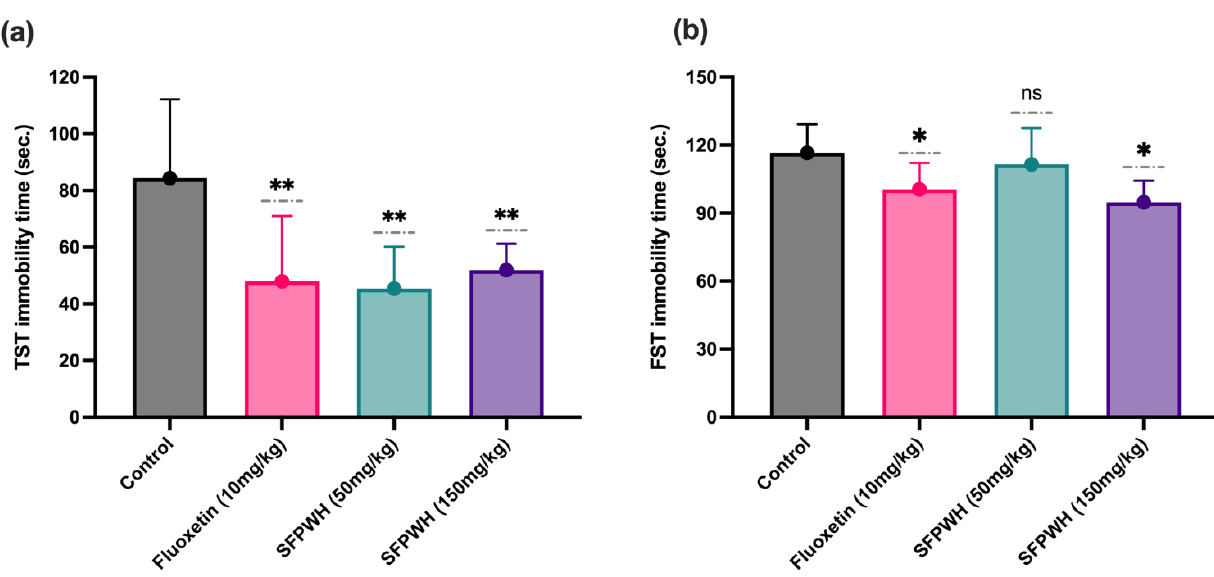
Figure 2. Effect of safflower hot water extract on immobility time in TST. ( a ) Effect on overall immobility time in TST-induced stress in mice. ( b ). Effect on overall immobility time in FST-induced stress in mice. ns = non-significant, * and ** indicates significantly different at p < 0.05 and p < 0.01, respectively versus untreated group, Student t-test.